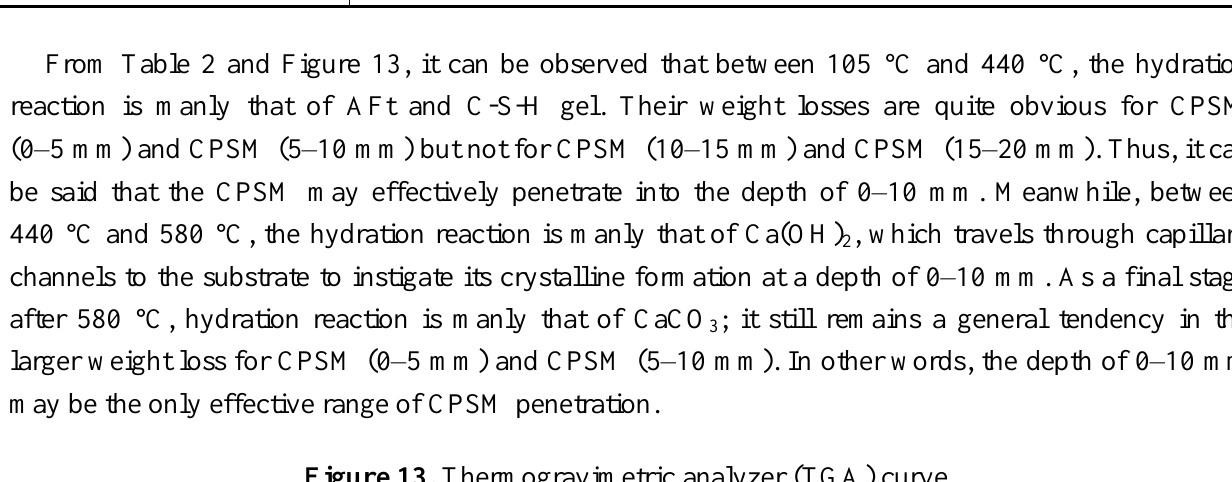
Figure 13. Thermogravimetric analyzer (TGA)